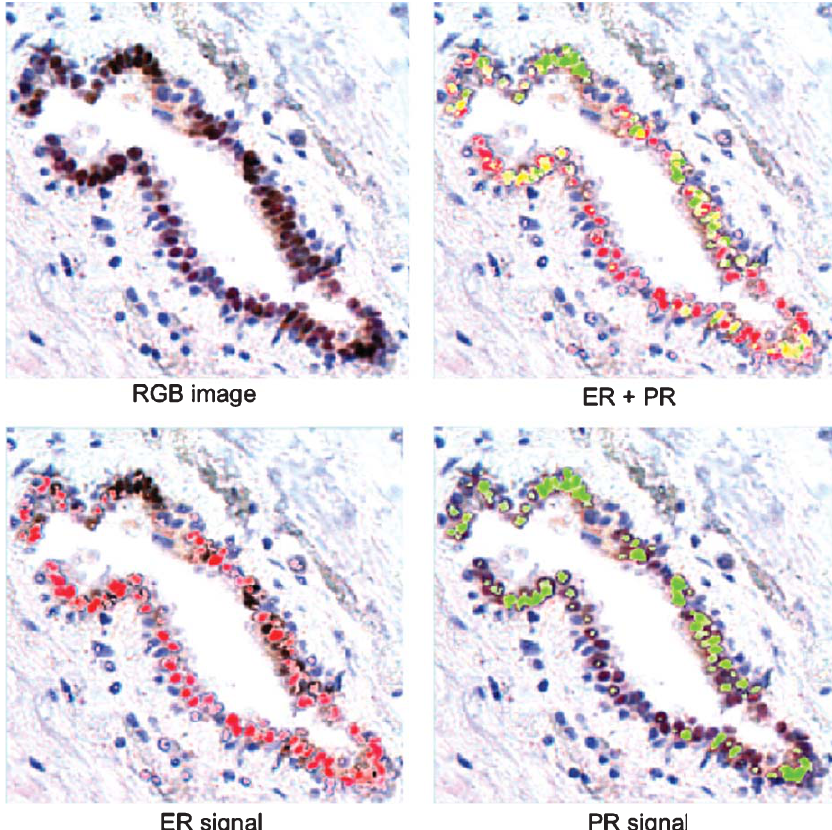
Fig. 9. Breast duct chromogenically stained for ER and PR, spectrally imaged in bright field and signals